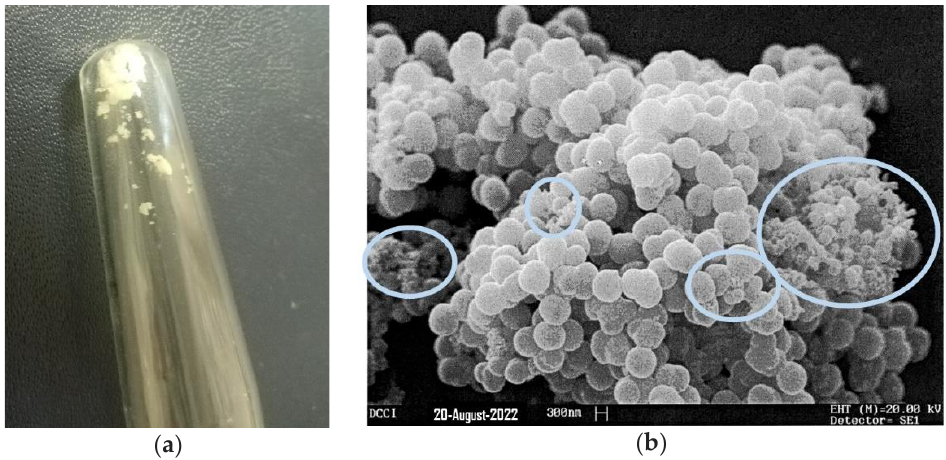
Figure 8. Lyophilized CP1OP2-Hgel ( a ); a representative SEM micrograph of a freeze-dried sample of CP1OP2-Hgel ( b ).